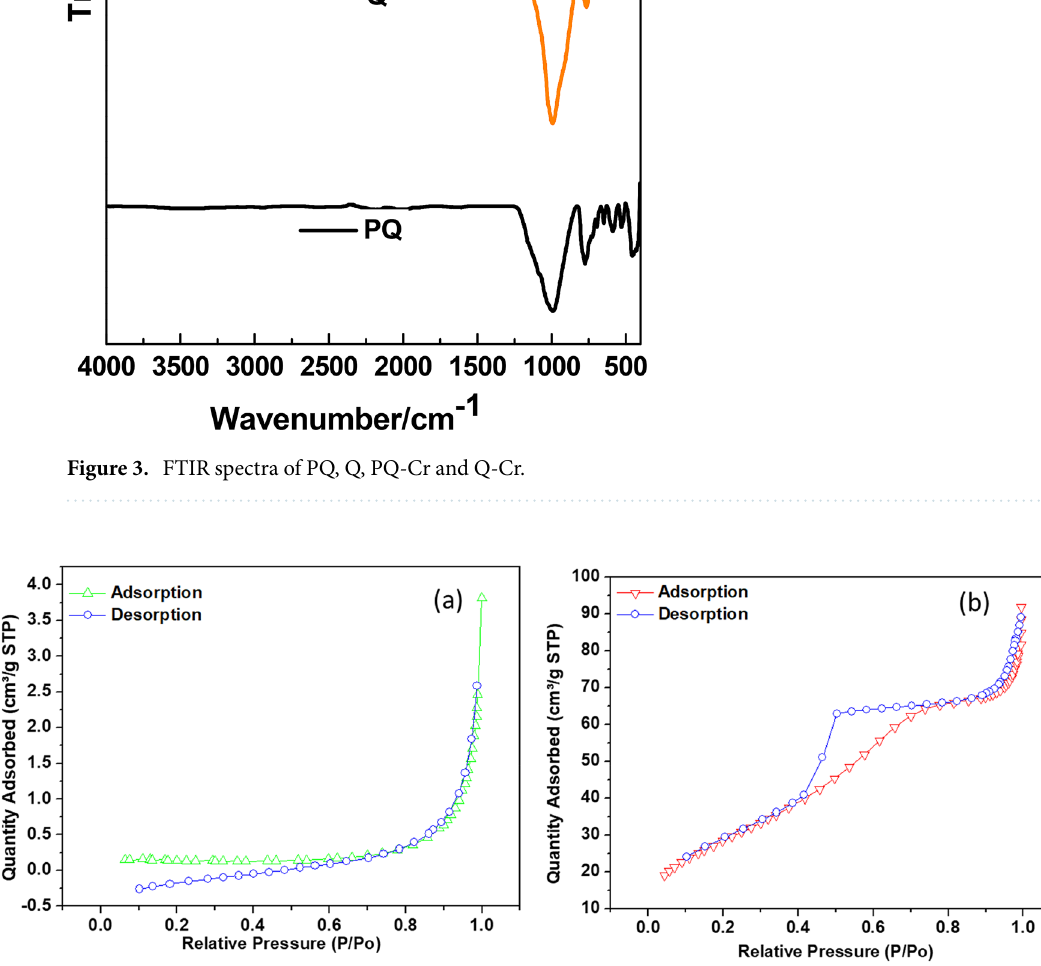
Figure 4. The nitrogen adsorption–desorption curves of ( a ) PQ and ( b ) Q.